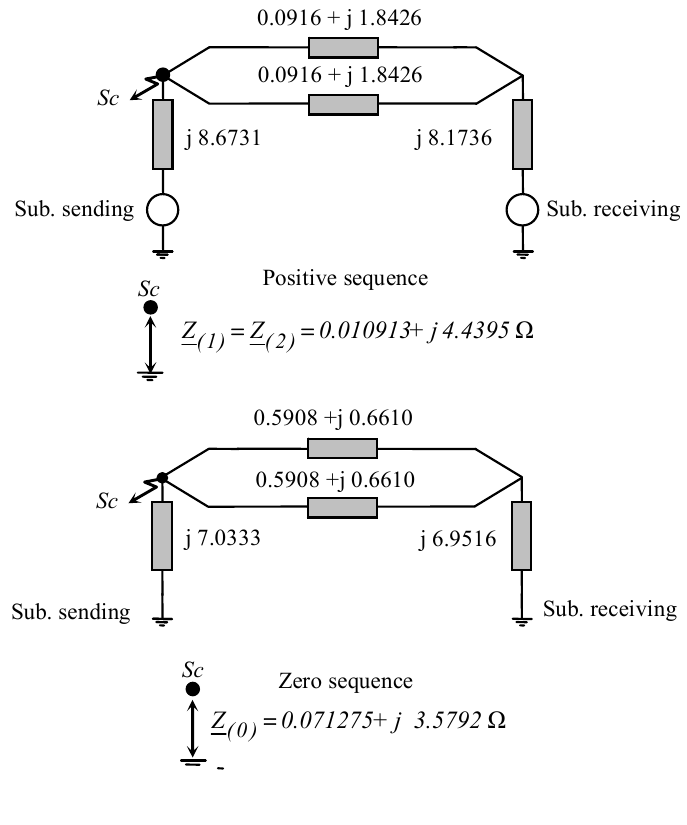
Figure 19. Faulted double circuit UGC: positive and zero sequence circuit for single-phase short circuit at